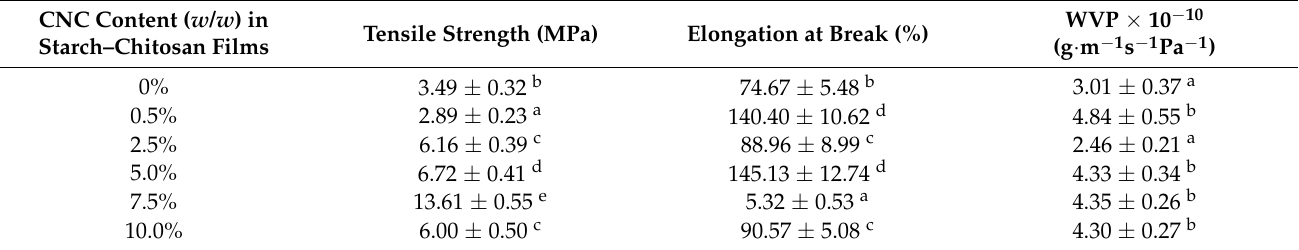
Table 4. Physicochemical properties of starch–chitosan biodegradable films reinforced with cellulose nanocrystals